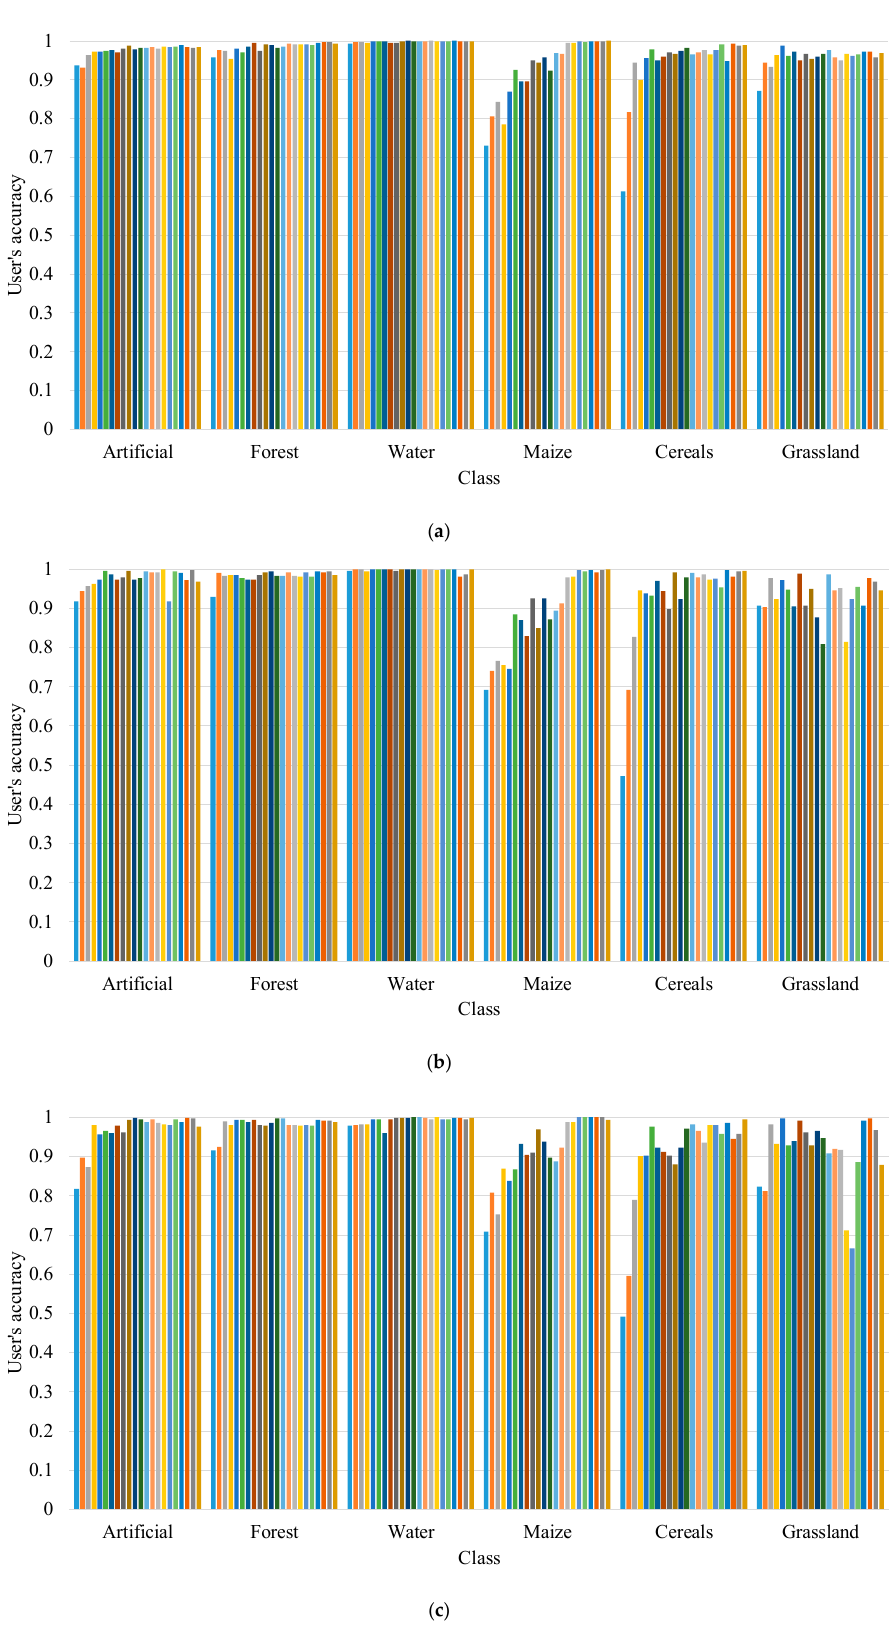
Figure 6. The user’s accuracy (UA) of each class with an increasing number of images used at different segmentation scales for Study Area 1. ( a ) Scale 50, ( b ) scale 100, and ( c ) scale 150. The colored bars from left to right represent the number of images from 1 to 20.